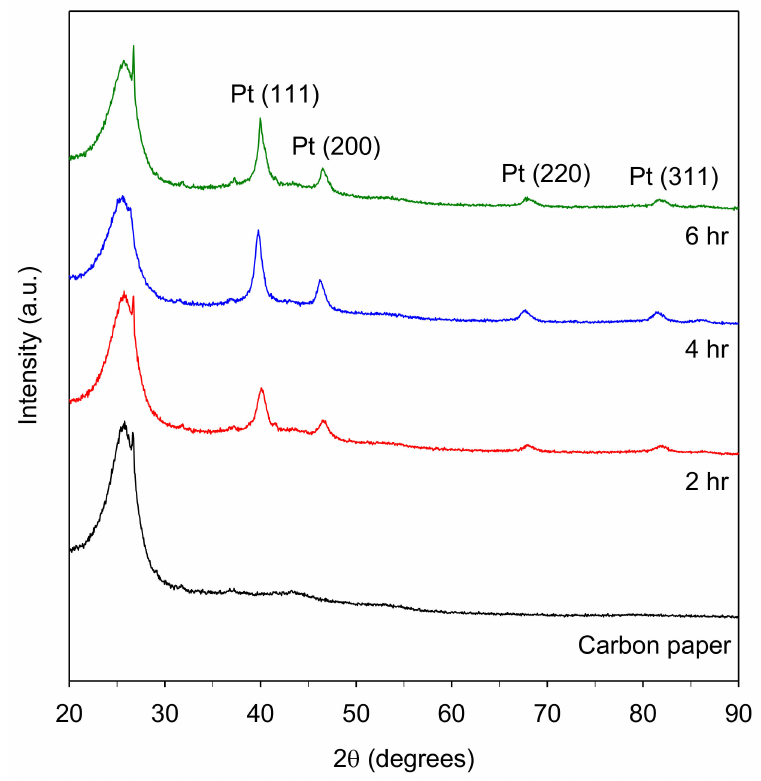
Figure 5. XRD patterns of Pt-deposited carbon paper fabricated by SCD at 80 ◦ C and various time intervals by thermal reduction at 250 ◦ C for 2